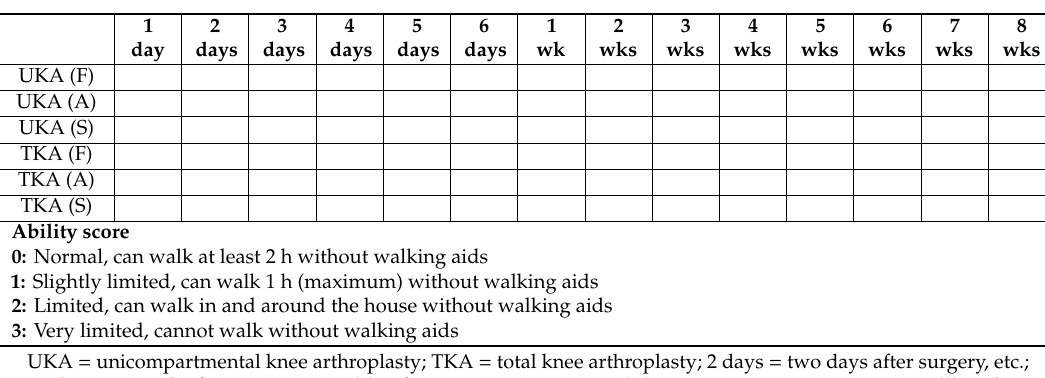
Table 1. Example of the Delphi panel questionnaire, in this case, for the activity “Walking without walking